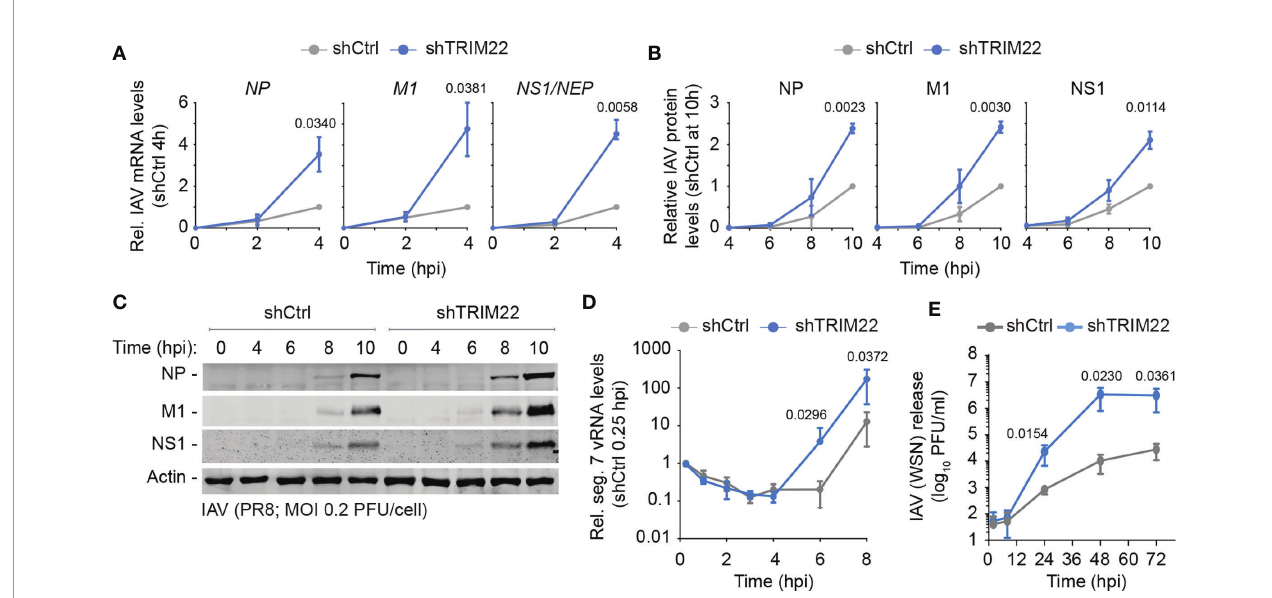
FIGURE 5 | Constitutive TRIM22 expression restricts the onset of IAV transcription. MRC5t shCtrl and shTRIM22 cells were infected with IAV (PR8) at a MOI of 0.2 (A – C) or 0.05 (D) PFU/cell (based on MRC5t titres) and harvested at the indicated time points. (A) qRT-PCR quantitation of IAV NP , M1 , and NS1/NEP mRNA levels. Values normalized to infected shCtrl samples at 4 hpi. n=3, means and SD shown. (B, C) Quantitation of viral protein (NP, M1, NS1) expression derived from western blots of infected WCLs. Actin is shown as a loading control. Values normalized to actin and expressed relative to levels in infected shCtrl cells at 10 hpi. n=3, means and SD shown. (A, B) One sample two-tailed t test against a theoretical mean of 1; p-values shown. (D) Quanti fi cation of IAV vRNA seg. 7 levels by qRT- PCR. Values normalized to infected shCtrl samples at 0.25 hpi. n=3, means and SD shown. (E) MRC5t shCtrl and shTRIM22 cells were infected with IAV (WSN) at a MOI of 0.001 PFU/cell (based on MRC5t titres). Media were harvested at the indicated time points and IAV plaque titre determined on MDCK cells; n=3, means and SD shown. (D, E) ratio paired two-tailed t test; p-values